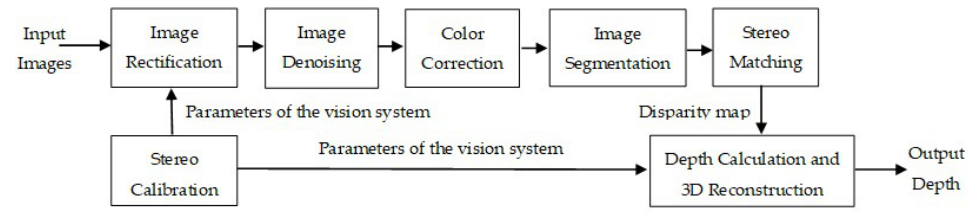
Figure 3. The binocular vision system processing flow chart.